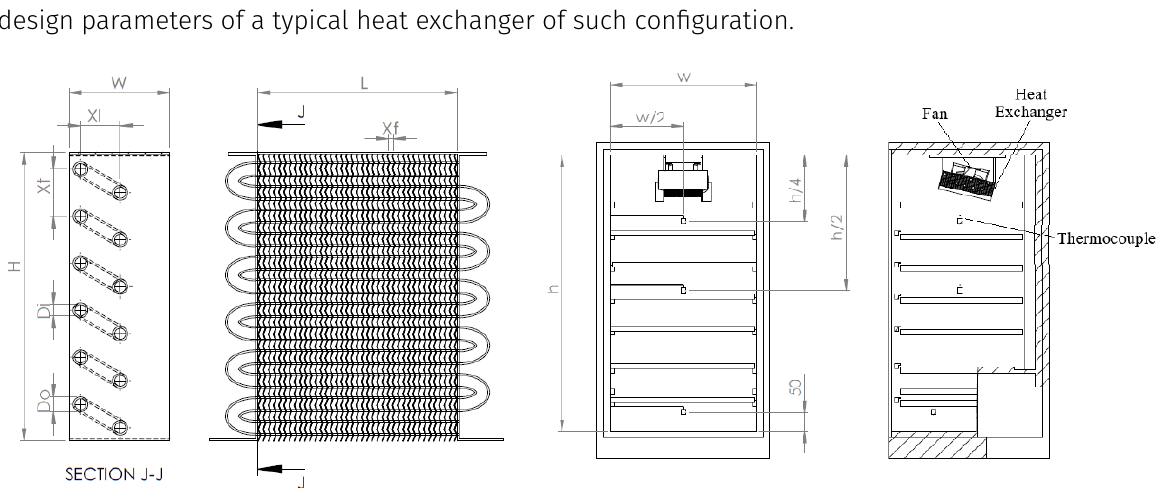
Figure 3. Schematic representation of a two-row wavy-type tube-fin heat exchangers and cabinet air temperature measurement locations and cold heat exchanger position inside the wine cooler cabinet. The heat exchanger dimensions are defined in Table I. The cabinet dimensions are w = 42 mm, h = 83 mm.